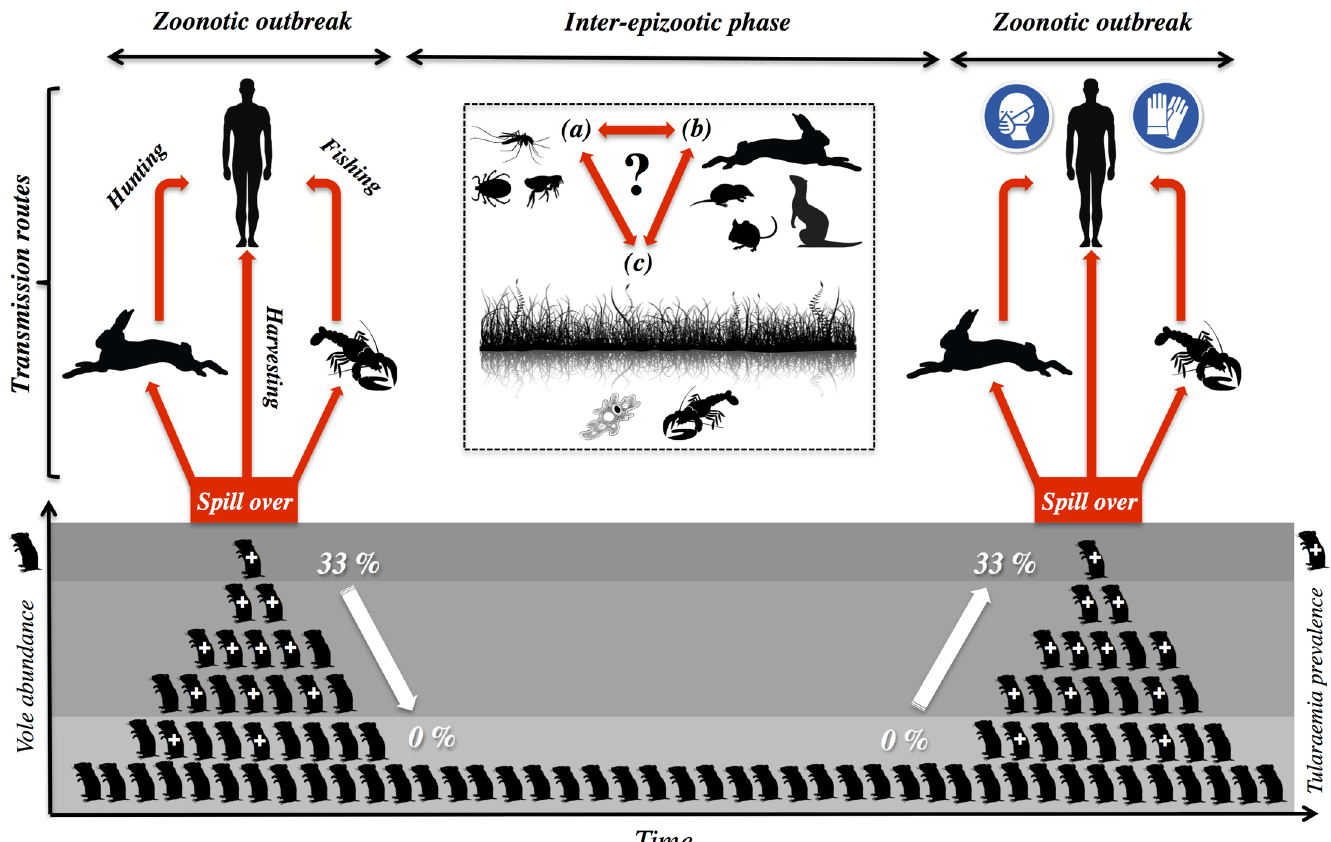
Fig 1. Dynamics of tularemia outbreaks in Northwest Spain. Commonvoles ( Microtus arvalis ) are key agents for this disease in Northwest Spain (Castilla-y-Leo´n region), where outbreaksof tularemiaamonghumans have beenendemic in farming landscapes since 1997 ( > 1,300cases in 1997– 2016). Voles have been identified as a main spilloverand amplification agent of tularemiabecauseepizooticand epidemic episodescoincidein time and space with vole outbreaks. When the rodents reach peak densities( > 1,000voles/ha), up to 33% of them are infected with tularemia. Therefore, as vole numbers increase,so does the bacterium in the environment. Transmission routes of tularemiato humans duringzoonoticoutbreaks include(i) direct contact with wildlifespecies such as hares or crayfish, which coexist with voles in the same habitats, and (ii) trough inhalationduringthe harvestingof vole- infested crop fields. At low vole densities,the bacterium is not found among the rodents, indicating that, betweenvole outbreaks, populationsof F . tularensis subs. holarctica may remain at lower numbers, associatedwith some yet-unknownreservoirs. Enzootic cycles in local wildlifeother than voles, includinghematophagous arthropods(a) and other small- and medium-sized mammals, (b) may also contribute to sustainingthe bacteriain the environmentduringinter-epizootic periods. Water is a main habitat for reservoir candidates (c) becauseit is a well-known favorablehabitat for tularemia (most especiallyin these semiaridlandscapes of Northwest